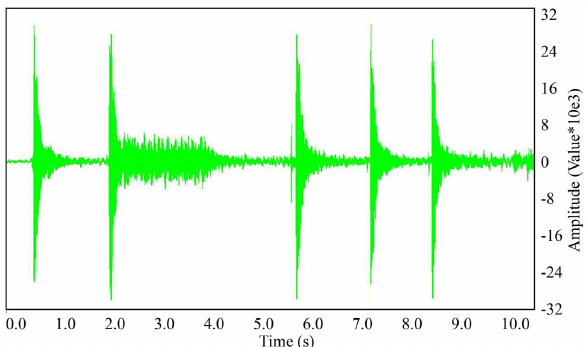
Fig. 1. Normalized recorded responses to five metal rod strokes, 50 %